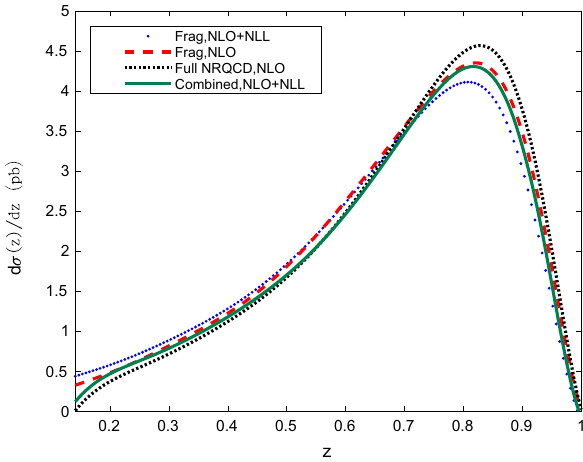
Fig. 7 The differential cross sections d σ/ dz for the production of the B c ( 2 1 S 0 ) meson at the Z pole under different approaches